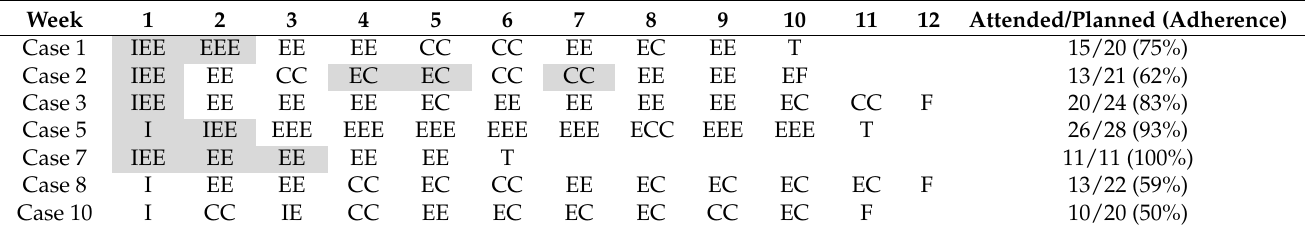
Table 3. Delivery of the intervention to participants by